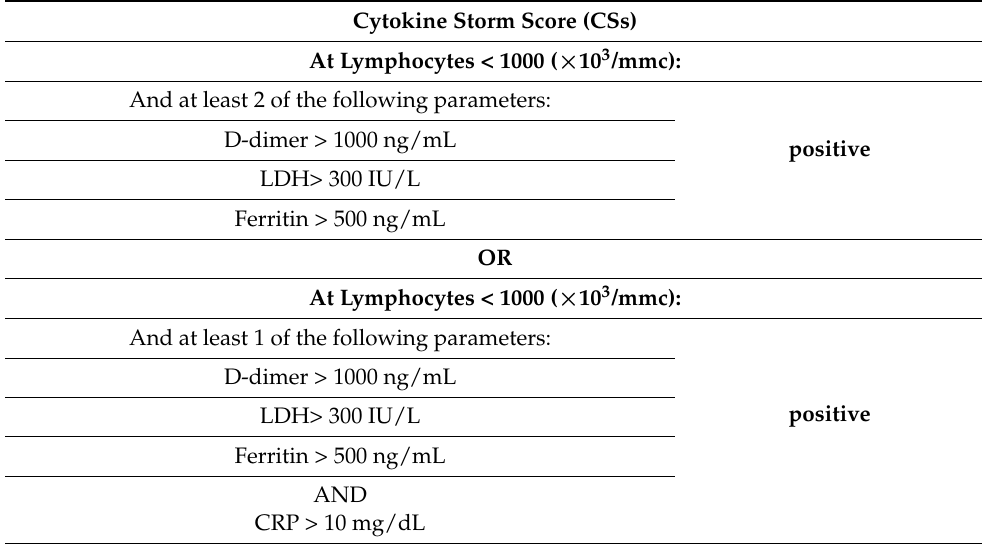
Table 1. Definition of Cytokine Storm score (CSs); (LDH: Lactate dehydrogenase; CRP: C-reactive